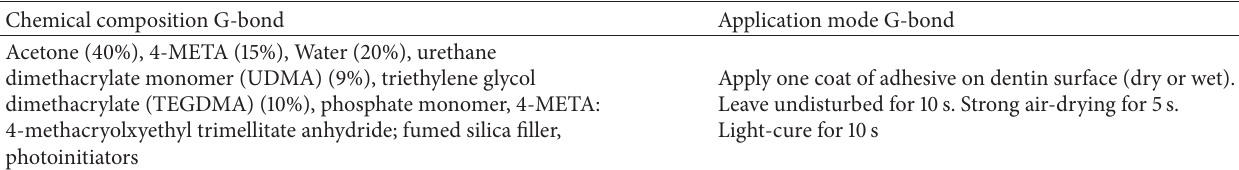
Table 1: Chemical composition and application procedure of G-bond, according to the manufacturer. Chemical composition